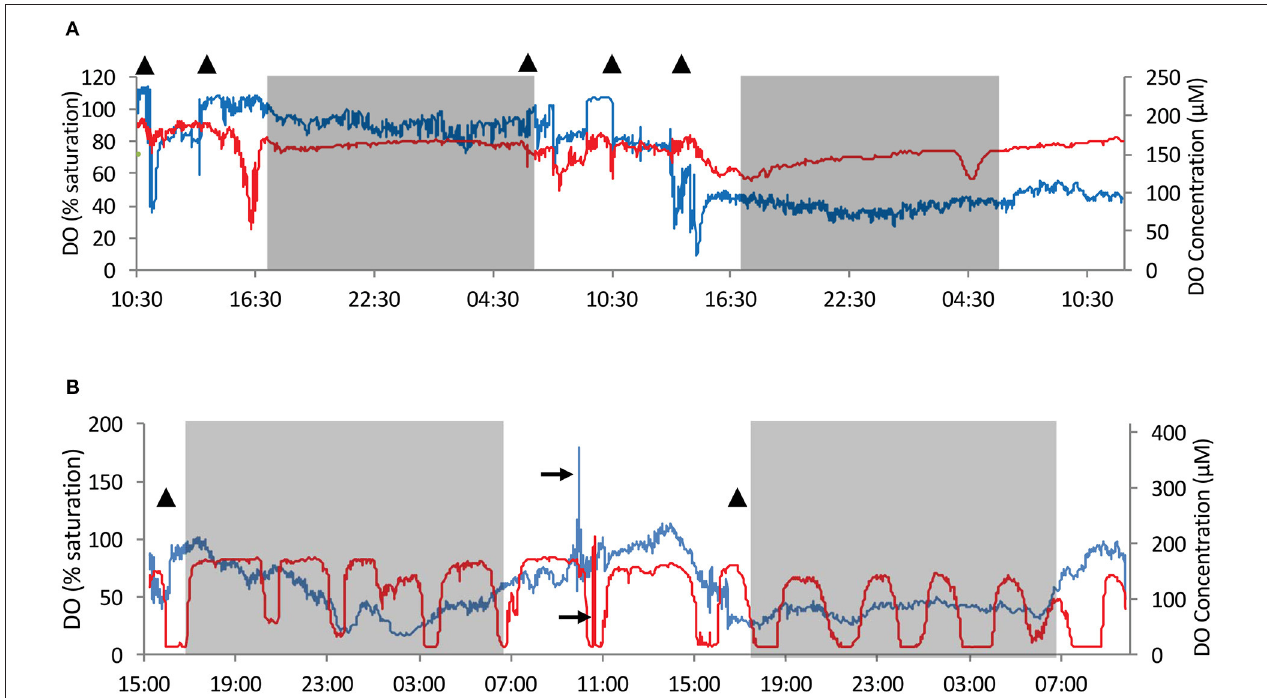
FIGURE 5 | An example of time series of dissolved oxygen (DO) concentration and saturation in the water exhaled from the osculum and in the sponge tissue (red–tissue, blue–osculum). Sponges T3 and T2b were chosen as examples as they present very different behavior patterns. (A) DO measurements in T3 over 48 h. (B) DO measurements in T2b over 42h. T2b represents a second set of measurements taken in the individual T2 but at a different osculum and locality within the sponge. Time series of T0, T1, and T2 are given in Figures S3–S5. Gray shade– night time. Triangles–times at which qualitative and/or quantitative flow speed was measured ( Figure 2 and Figures S6–S9). 100% saturation = 208 µ mol L − 1 . Black arrows mark temporary repositioning of sensors to ambient water for performance